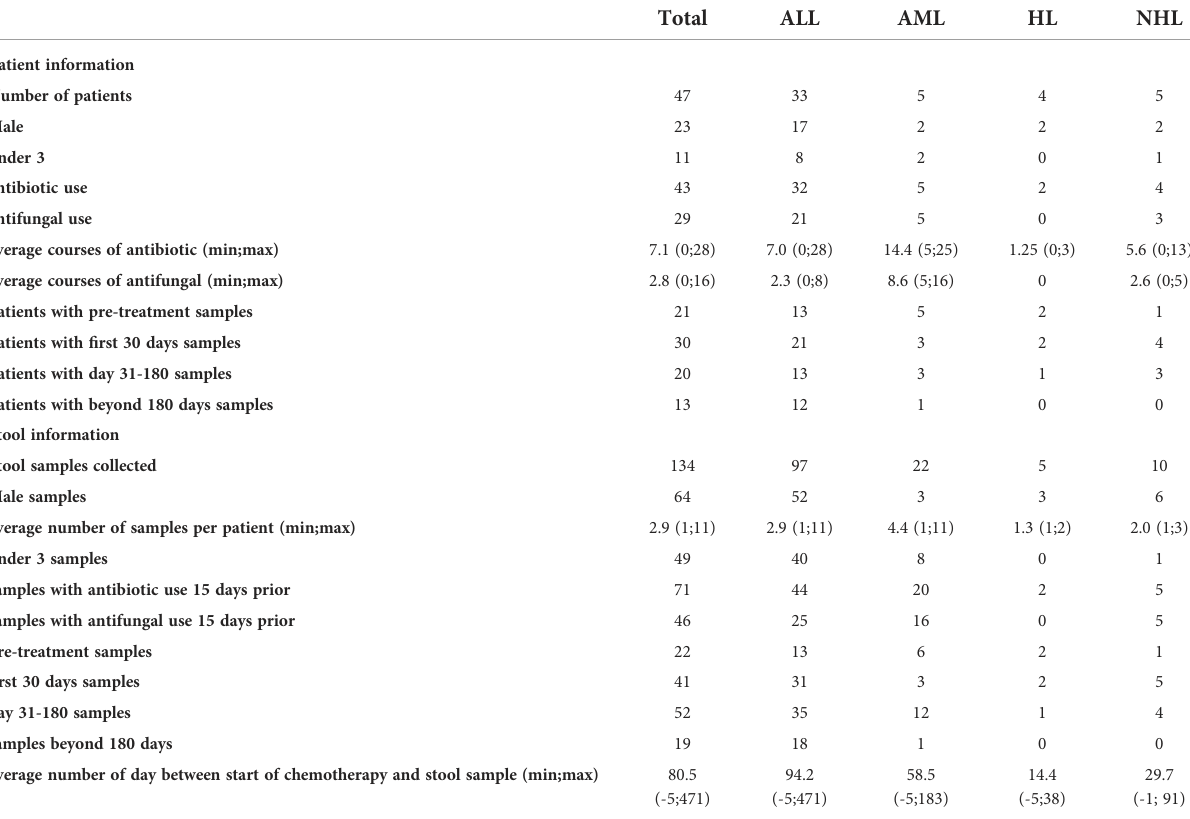
TABLE 1 Patient and sample population